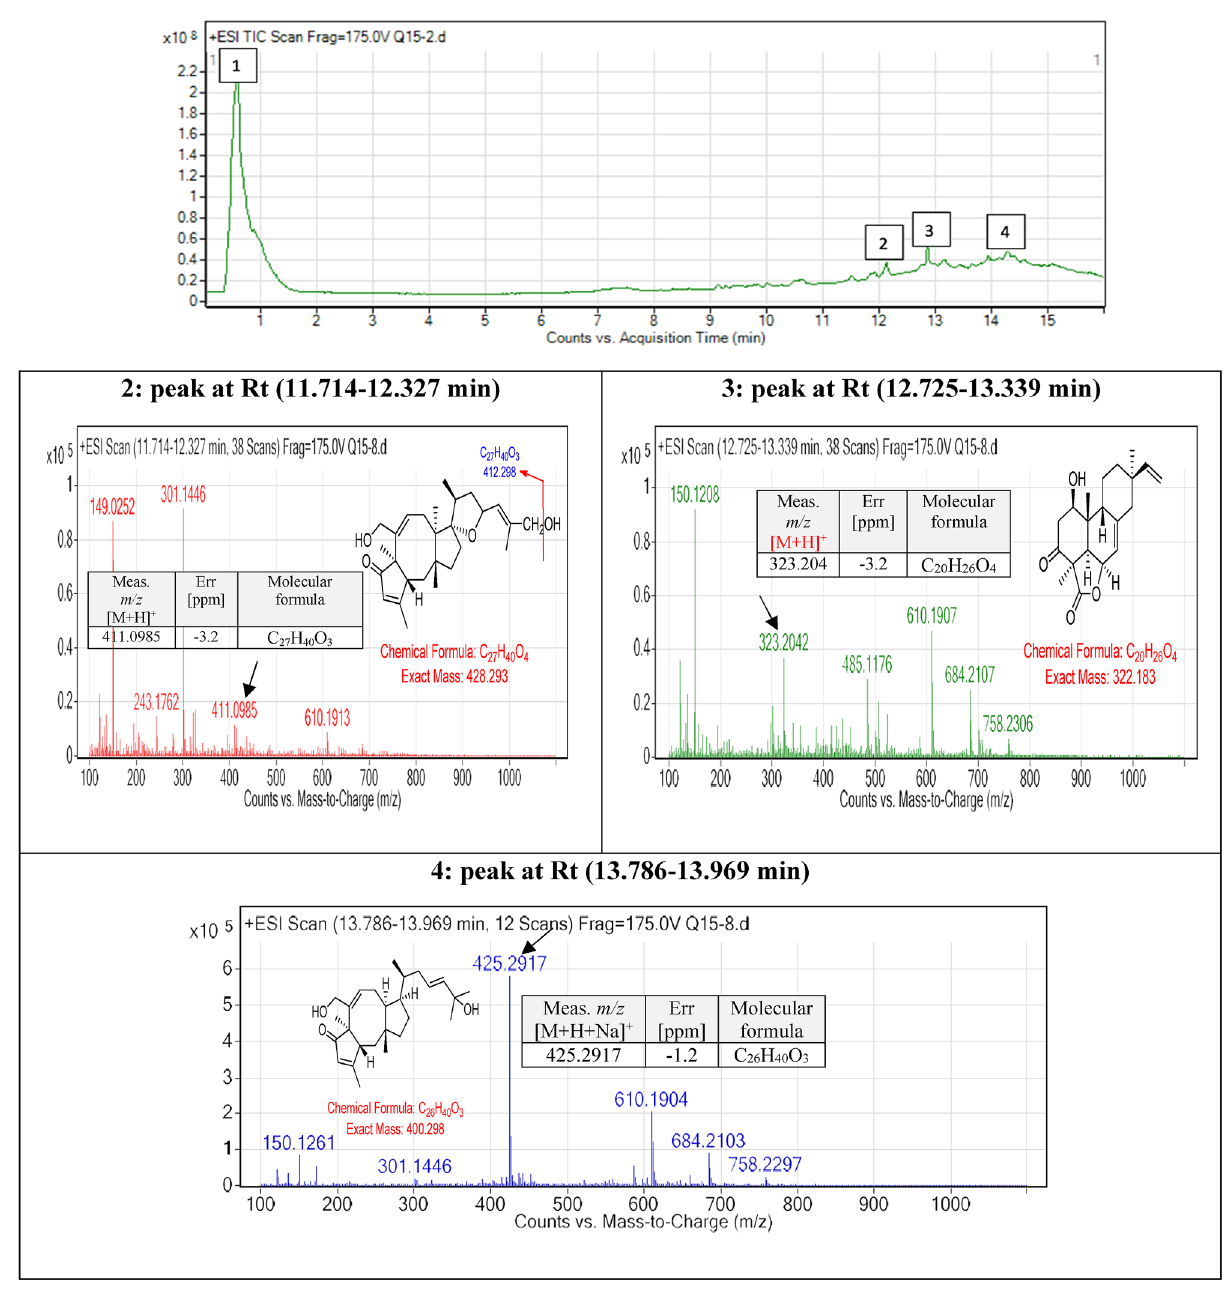
Figure 13. Metabolomic profiling using LC–MS, chromatogram of Bipolaris sp. extract presenting the molecular mass different compounds and base peak chromatogram of Bipolaris sp. crude extract and identified secondary metabolites which are: ( A ) is 25-hydroxyphiobolin I, ( B ) is1β-hydroxy momilactone and ( C ) is bipolatoxin E. Meas m/z implies measured